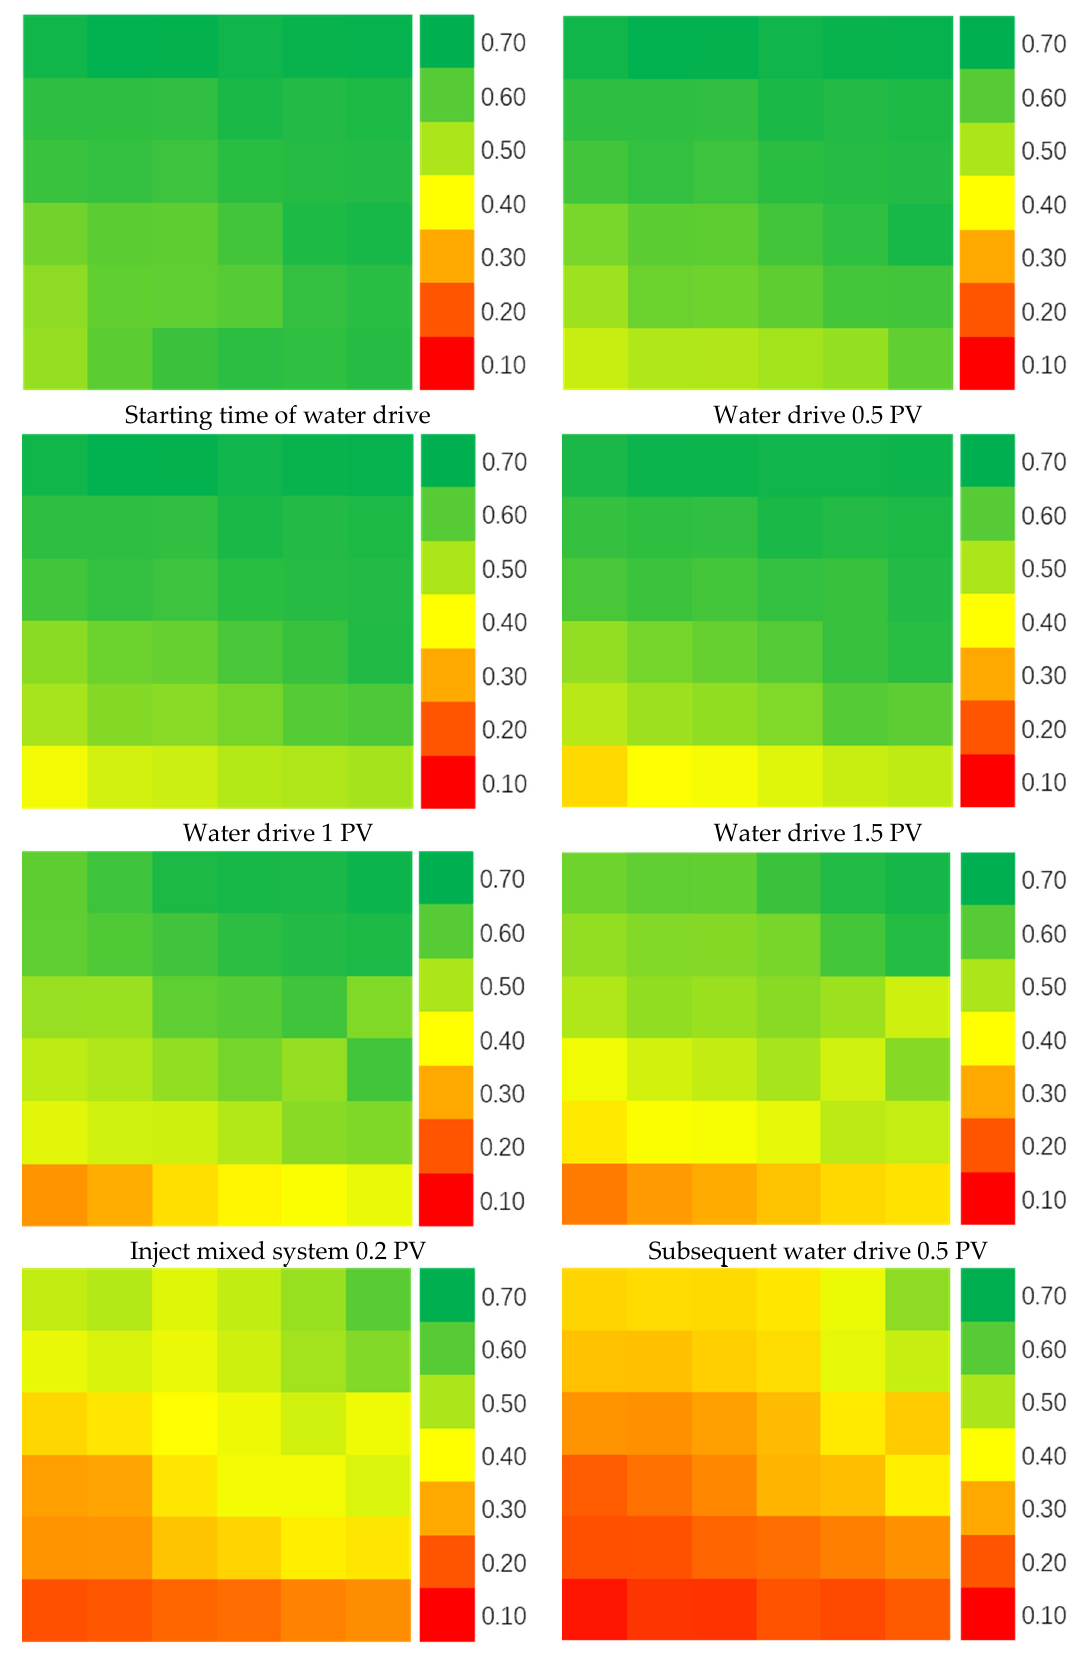
Figure 9. Oil saturation distribution.